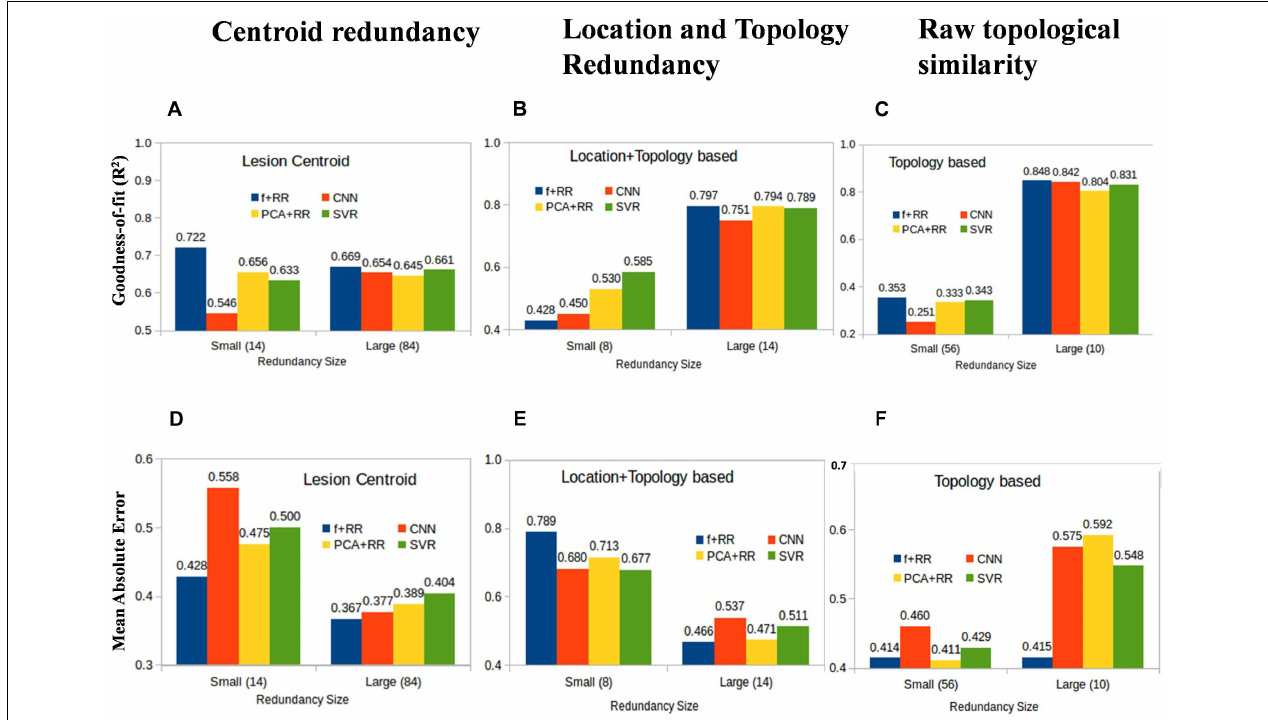
FIGURE 7 | Average prediction performance for images having large vs. small redundancy levels with other images. Performance is measured by both goodness of fit ( r 2 ) (A–C) and mean absolute error (MAE) (D–F) . For these definitions of redundancy, almost all models perform very similarly in the image set in which redundancies are high (right-sided bars in all panels). In the small redundancy set, the Hybrid model comprehensively outperformed all other models, except in the location + topology based similarity. Values in the brackets of x -axis labels represent the number of images included in small and large redundancy